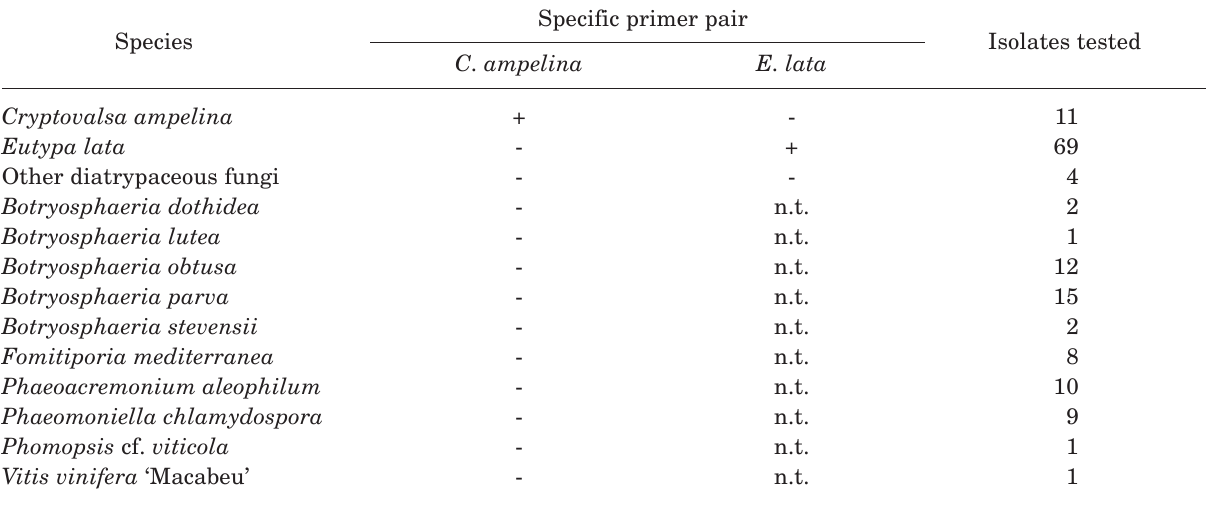
Table 1. Specificity of the primer pair Camp-1/Camp-2R for the identification of Cryptovalsa ampelina . Legend of symbols: +, band of expected size; -, no bands; n.t., not